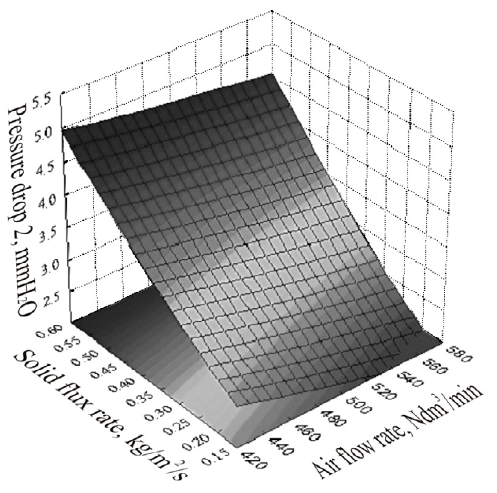
Fig. 10. Total pressure